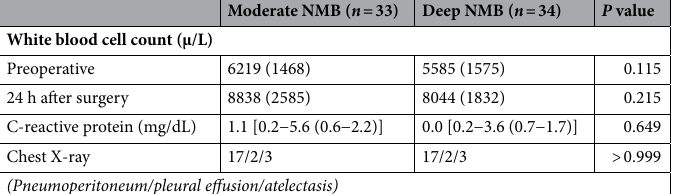
Moderate NMB ( n = 33) Deep NMB ( n = 34) P value White blood cell count